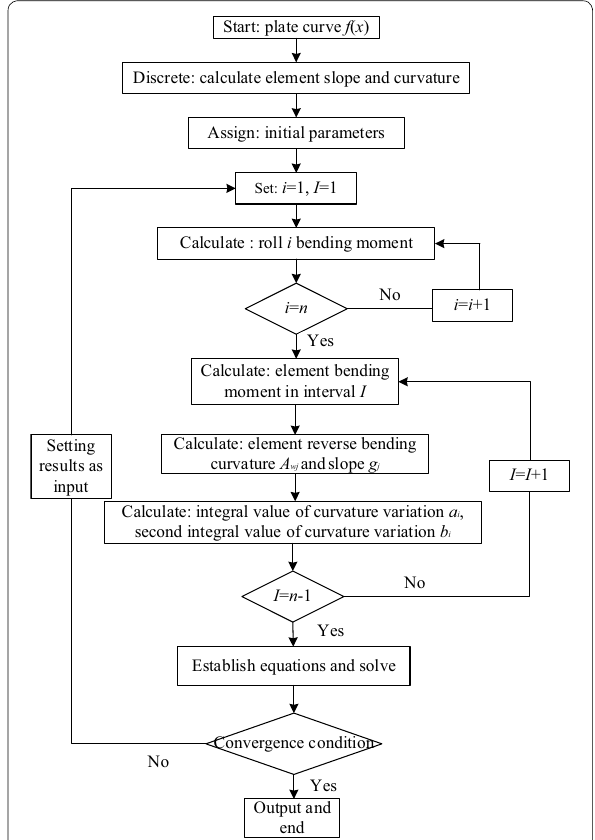
Figure 3 Curvature integration model analysis flow chart in the contact establishment